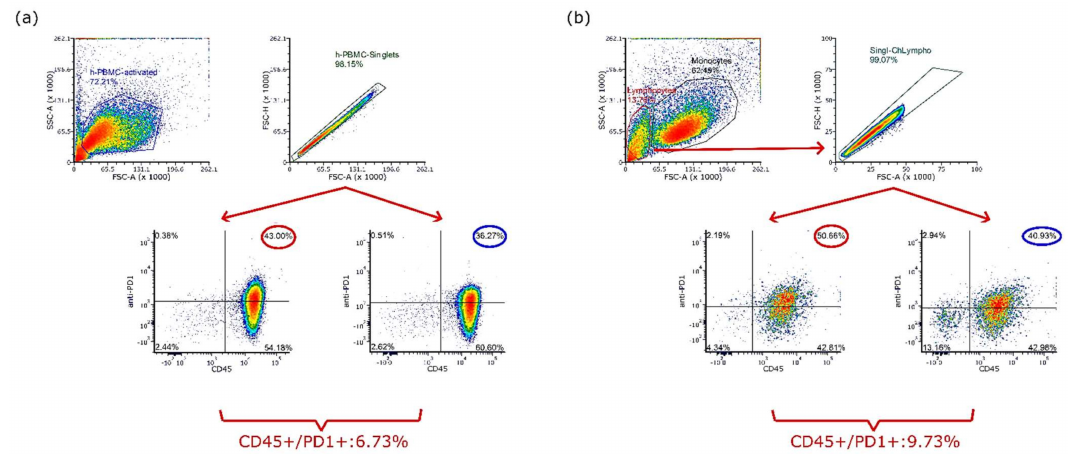
Figure 3. Pembrolizumab binding assay measured by flow cytometry. Before the FACS analysis, the chicken splenic monocytes and human PBMCs were pre-activated using anti-CD3 Ab at 1 µ g/mL and IL2 at 10 ng/mL (chicken or human species), respectively, for 6 days. The cells were then labelled with fluorochrome-conjugated anti-CD45 and fluorochrome-conjugated pembrolizumab for FACS analysis. One human IgG4 Kappa isotype control Ab was also applied for excluding the non-specific binding: ( a ) By subtracting non-specific binding revealed by isotype control, 6.73% of activated human PBMCs were CD45 + /PD-1 + ; and ( b ) 9.73% of inactivated chicken splenic lymphocytes were CD45 + /PD-1 +